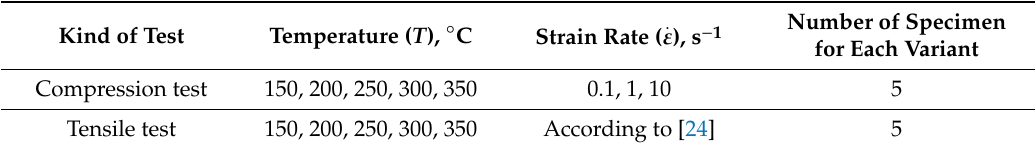
Table 3. Parameters of compression and tensile tests.